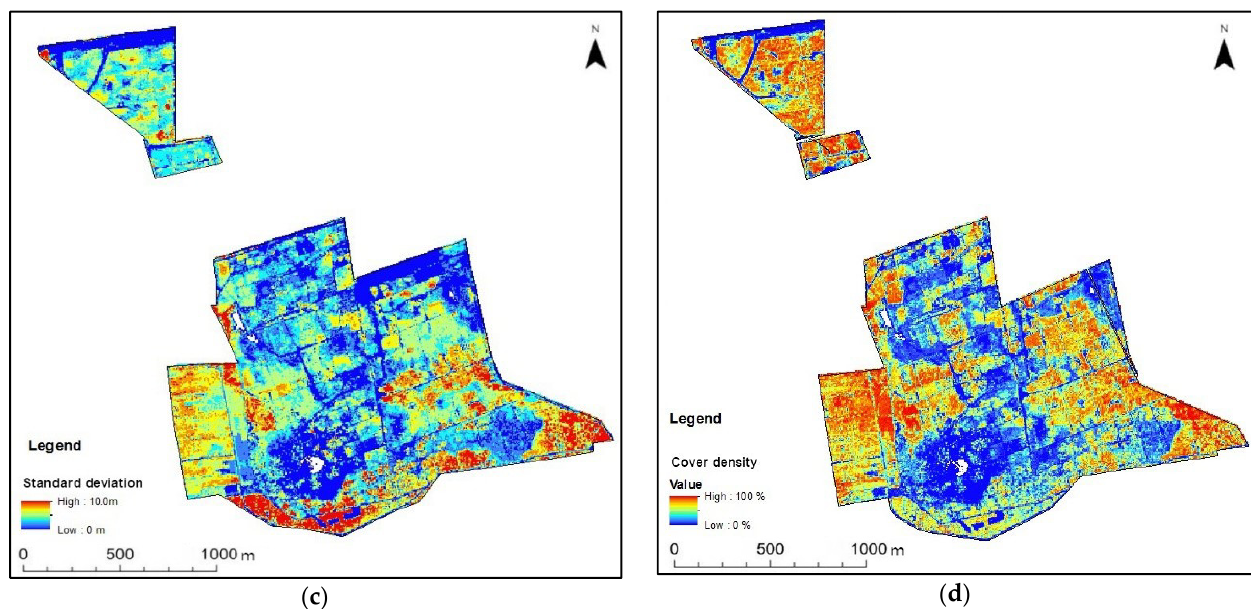
Figure 8. LiDAR parameters: ( a ) normalized DSM; ( b ) height of vegetation (95 th percentile); ( c ) standard deviation of height; ( d ) cover density (with a value of 0–100%). Figures 9–11 show the detailed parameters of vegetation (in different stages of growth) as histograms and profiles from the ALS data (vegetation are green points, and the ground is pink). Examples are shown for low (transitional woodland shrub), medium, and high vegetation (broad-leaved forest and coniferous forest) [42].